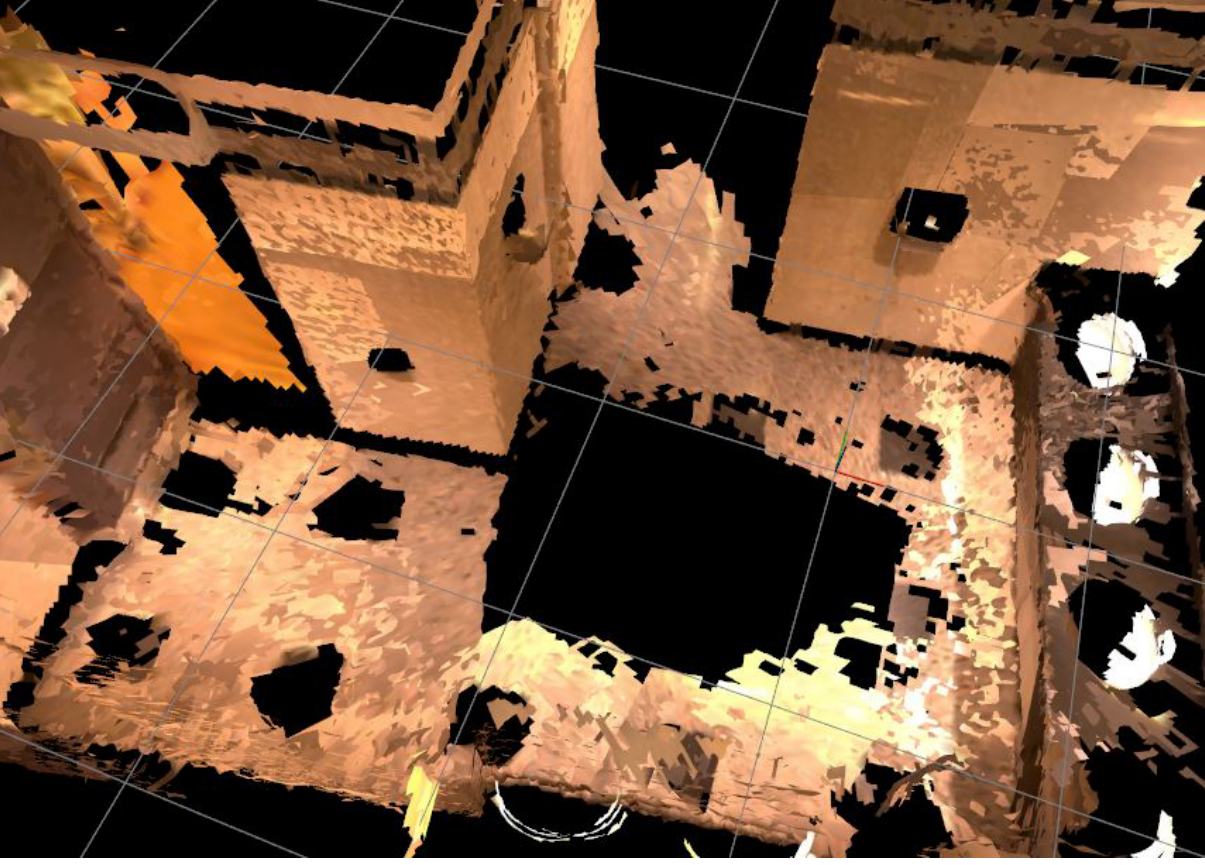
Figure 2. Map of a hotel bathroom to explore RTAB-Map’s